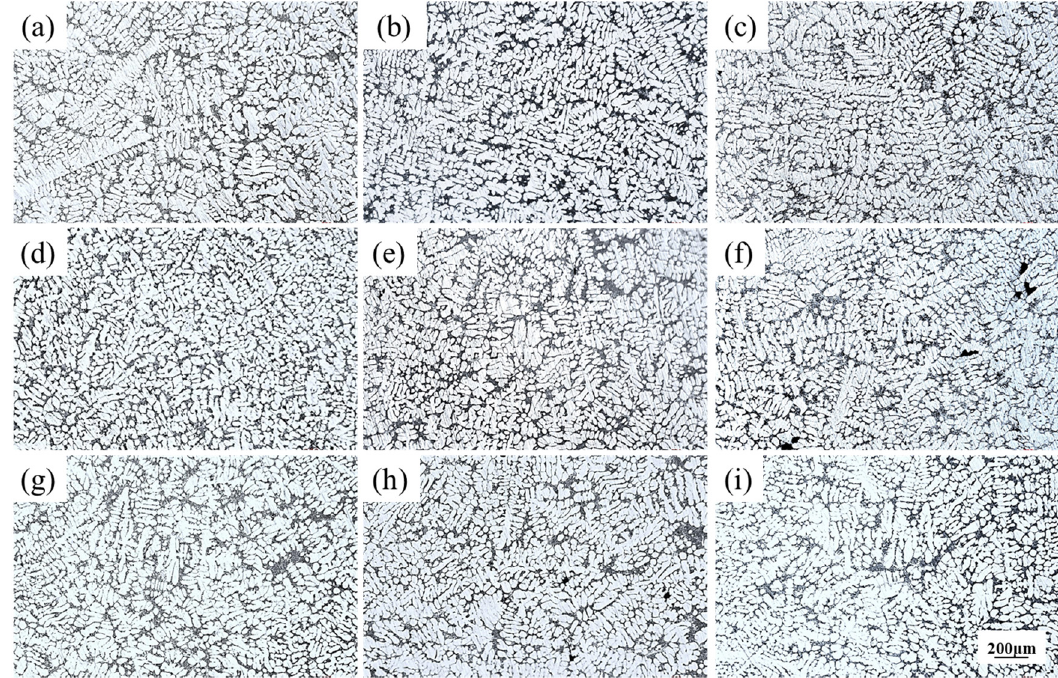
Figure 4: Alloy microstructures under di ff erent conditions: ( a ) Group 1, U 0 ; ( b ) Group 2, U 1 ; ( c ) Group 2, U 2 ; ( d ) Group 3, U 1 ; ( e ) Group 3, U 2 ; ( f ) Group 4, U ( g ) Group 4, U ( h ) Group 5, U ( i ) Group 5, U 1 ; 2 ; 1 ; and 2